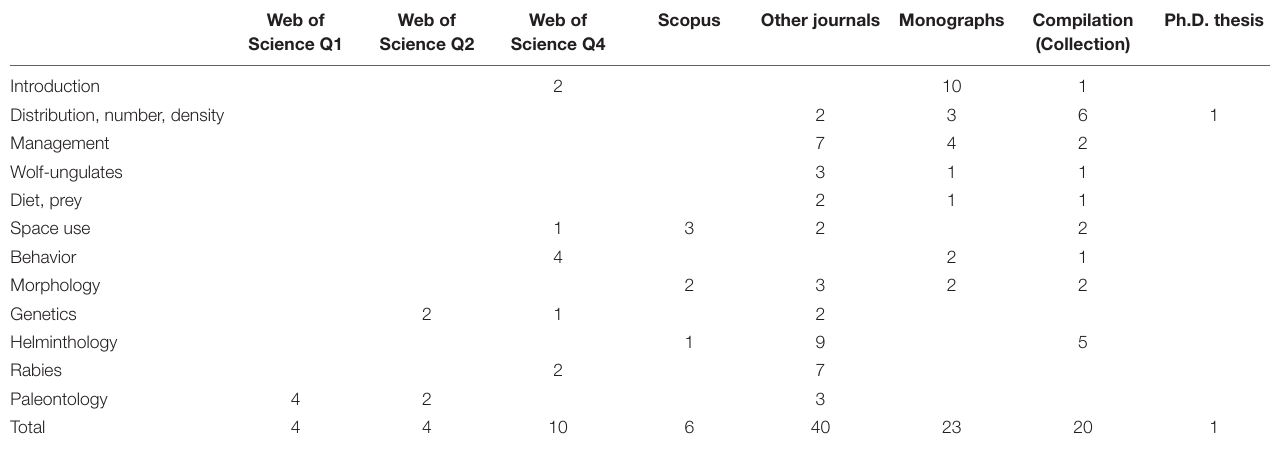
TABLE 1 | Distribution of publications by significance level in